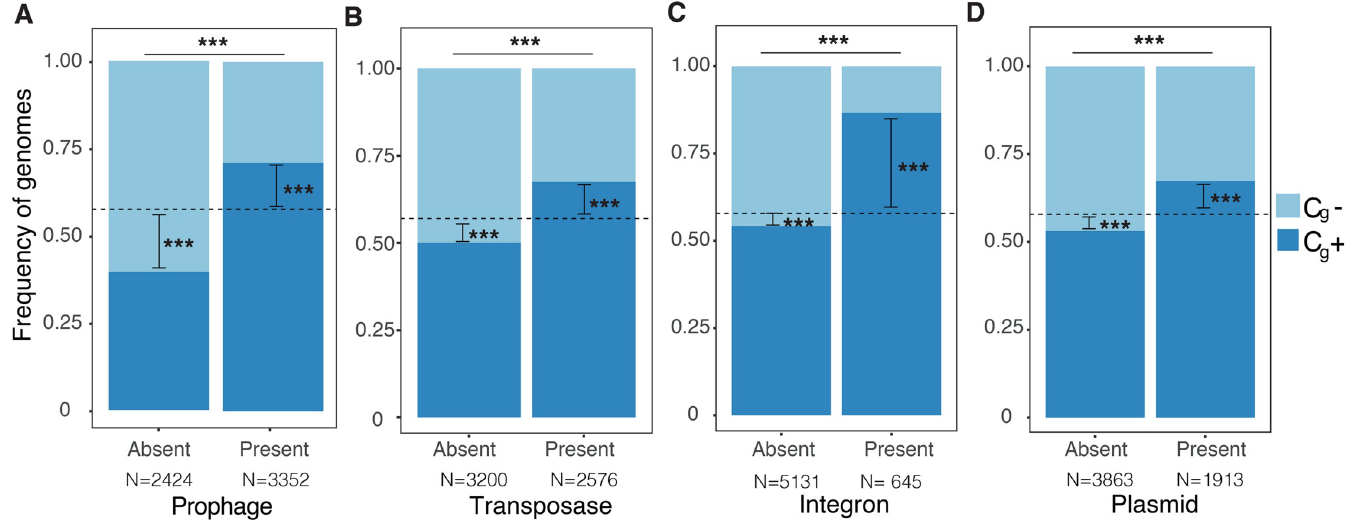
Fig 2. Co-occurrence between capsule systems and mobile genetic elements; Prophages (A), Transposases (B), Integrons (C) and Plasmids (D). Stars inside bars represent the result of two-tailed binomial tests to measure the difference between the observed over the expected events, indicated by the dashed line corresponding to the database bias (57%). The stars on top of the bars are the result of dependence tests ( χ 2 test). All statistics were corrected for genome size and phylogeny (see S3 and S4 Tables for details). ��� P < 0.001.